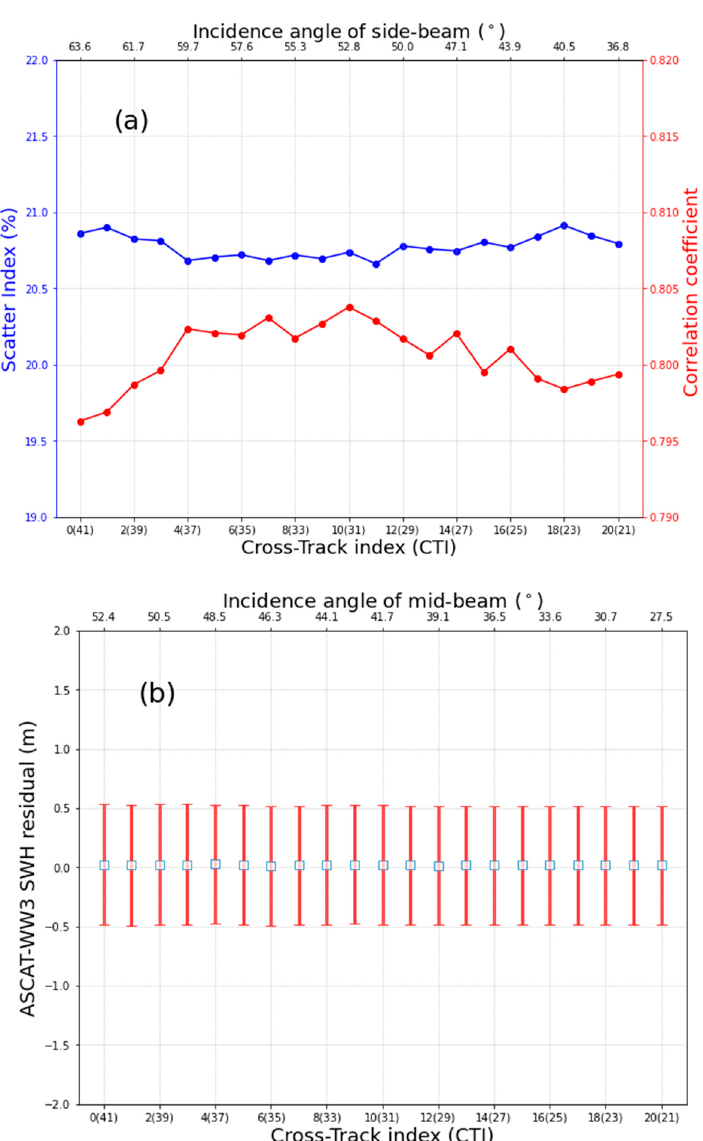
Figure 10. Performances of the ASCAT derived SWH against WW3 (test dataset) with respect to cross-track index and incidence angle of ( a ) side-beams and ( b ) mid-beam. ( a ) Scatter index (blue) and correlation coefficient (red). ( b ) Bias (box) and RMSE (error bar).